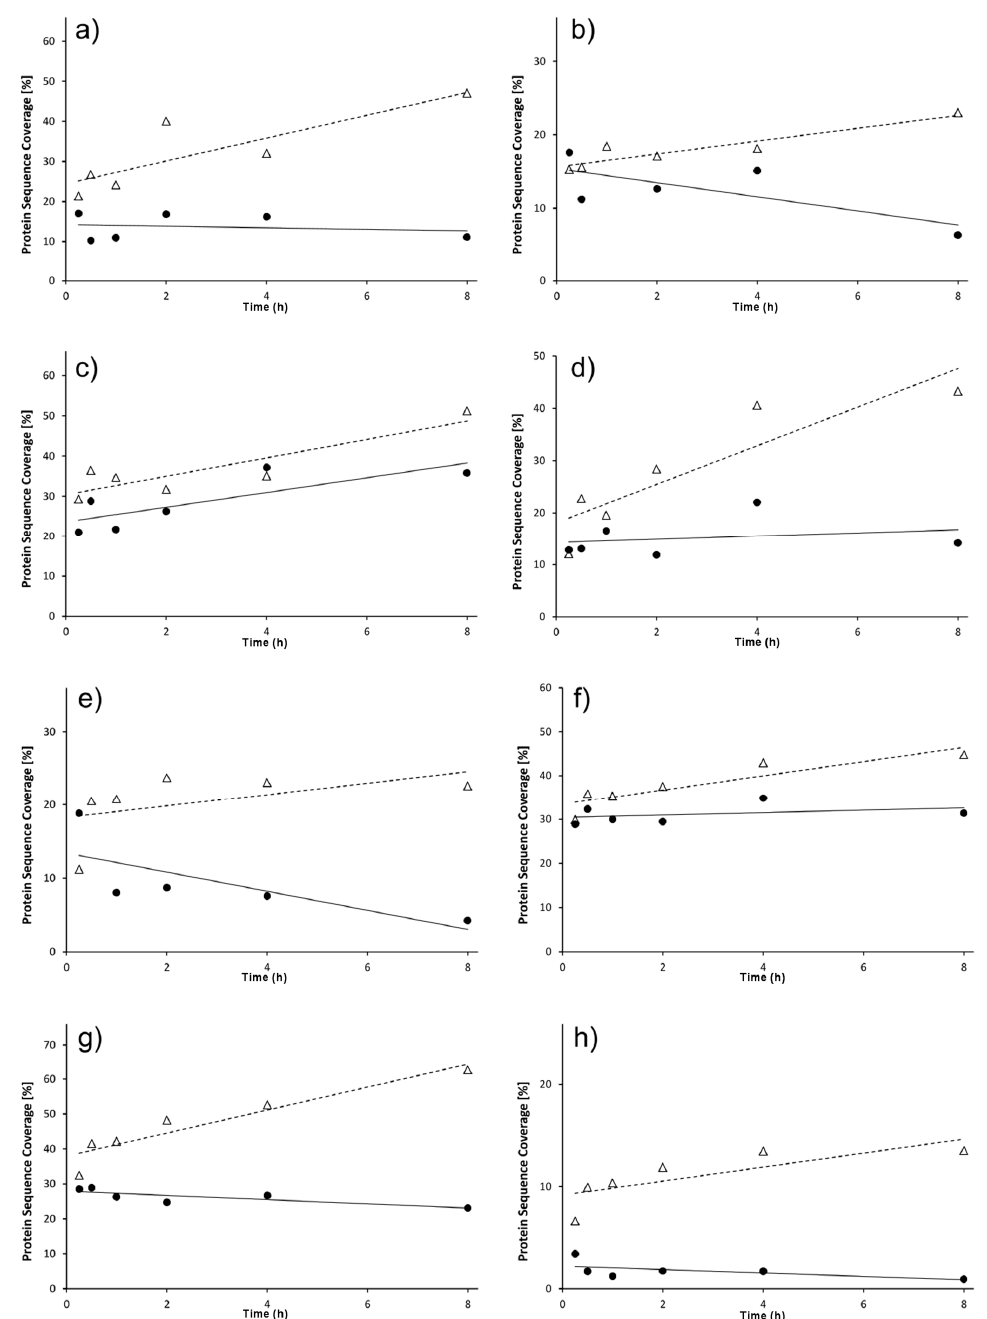
Figure 3. Protein sequence coverage as a function of time for proteins adsorbed onto native (dashed line and triangles) membranes and coated (solid line and filled circles) membranes. ( a ) Cystatin C (MW 13 kDa); ( b ) prostaglandin-H2 D-isomerase (MW 18.5 kDa); ( c ) apolipoprotein E (MW 34 kDa); ( d ) apolipoprotein A-IV (MW 43 kDa); ( e ) Ig gamma-1 chain C region (MW 41 kDa); ( f ) clusterin (MW 50 kDa); ( g ) serum albumin (MW 66 kDa); ( h ) coagulation factor V (MW 250 kDa).